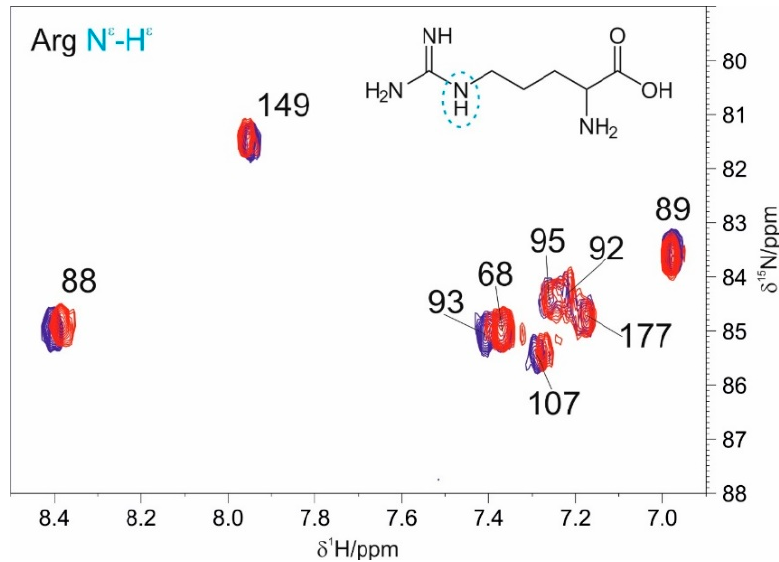
Figure 4. Overlay of 2D HN spectra recorded focusing on the arginine side chain region upon the addition of 1.2 equivalents of EP to NTD (blue reference, red addition of 1.2 equivalents of EP). The protein fingerprinting can be expanded by performing a set of 2D 13 C-detected NMR experiments (2D CON, 2D CACO, and 2D CBCACO) [54]. Preliminary to this, a 3D (H)CBCACON experiment [41] was also performed to complete the available assignment of NTD (BMRB: 34511 [22]). These experiments allowed us to assign 100% of the C α , C β , C’ 99.2% H N (G44 missing), and 99.2% N (including those from the 11 proline residues, 8% of the total protein composition, G44 missing) resonances in our experimental